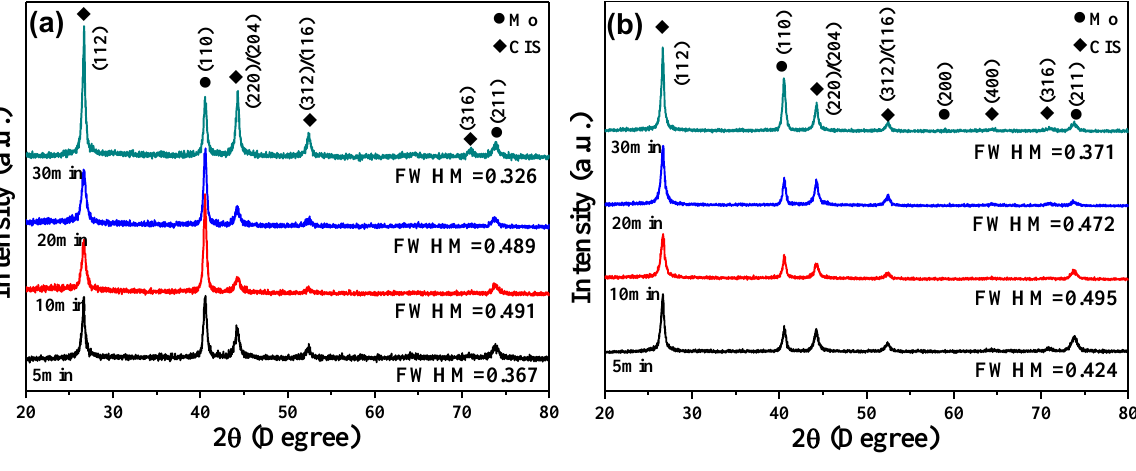
Figure 3. XRD patterns of the CIS absorber layers as a function of annealing time, with using solution volume was ( a ) 0.05 mL; and ( b ) 0.1 mL;